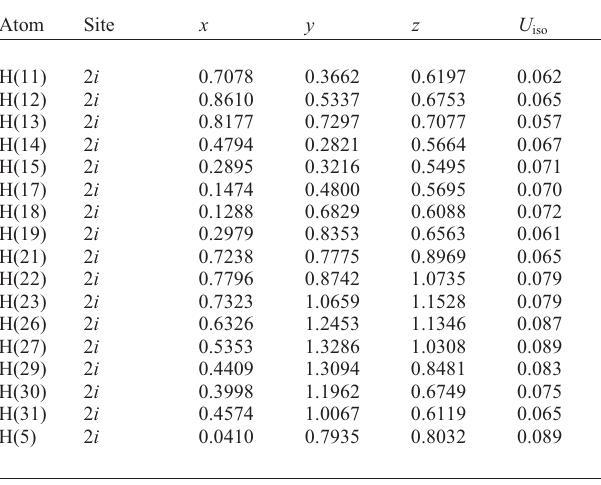
tifs with useful functional properties [4, 5]. The asymmetric unit of the title crystal structure contains one Ni(II) ion, two 1,10- phenanthroline ( phen ) ligands, and one tetrafluorophthalato ligand, and one cocrystallized tetrafluorophthalic acid molecule. Each Ni(II) ion is trigonal biyramidal coordinated by four N at- oms from two chelating phen ligands and one O atom of the twofold deprotonated tetrafluorophthalate ligand. The bond lengths of Ni–O are 1.963(2) Å. The bond lengths of Ni–N are 1.982(3) Å, 1.983(3) Å, 2.089(3) Å and 2.176(3) Å. In the com- plex, there exist intermolecular hydrogen bonds: d (O7–H7···O3) = 2.731(4) Å and d (O5–H5···O3) = 2.526(3) Å between both car- boxyl groups of tetrafluorophthalic acid and carboxylate group of theanionicligand.Inthecomplexthehydrogenbondsplayanim- portant role in forming by self-assembly and stabilizing the supramolecular structure. Table 2. Atomic coordinates and displacement parameters (in Å 2 ) . Atom Site x y z U